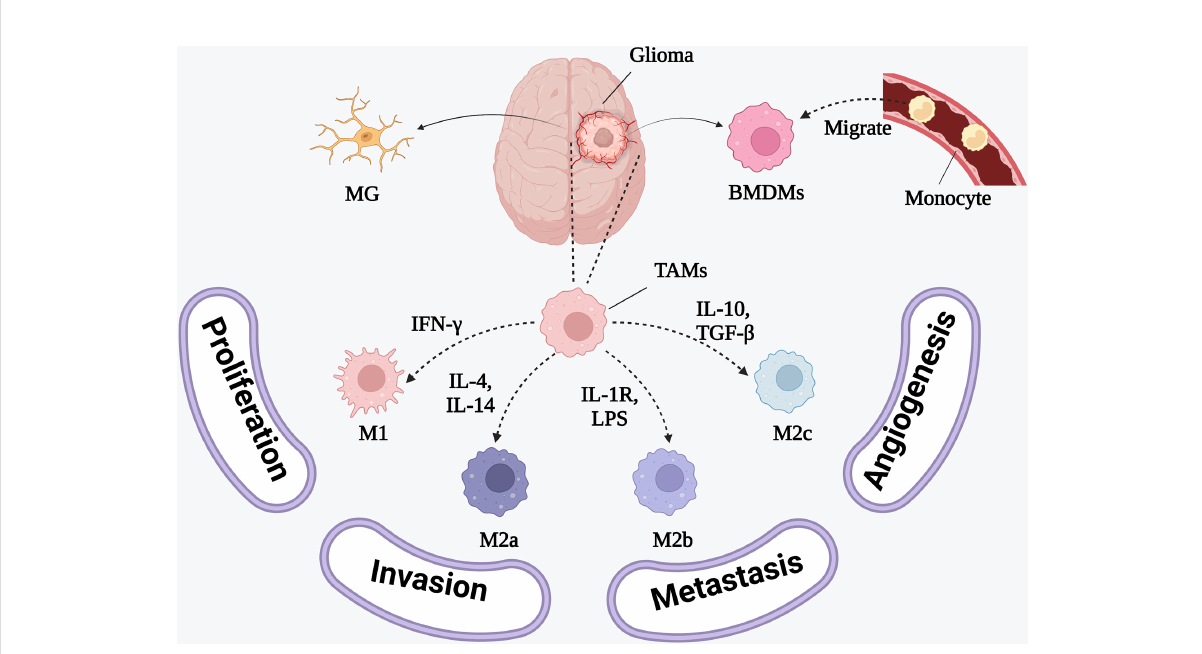
FIGURE 2 The phenotypes of BMDMs and the inducing cytokines. M1 polarized macrophages are induced by IFN- g to release proin fl ammatory cytokines. M2 polarized macrophages releasing anti-in fl ammatory cytokines consist of IL-4 and IL-13 activated M2a polarized macrophages, IL-1R ligands or immune complexes plus LPS activated M2b polarized macrophages and TGF- b and IL-10 activated M2c polarized